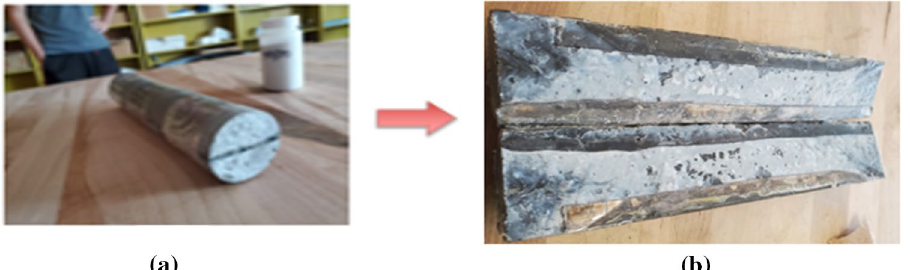
Fig. 1 A cut cement core sec- tion. a Fractured core before gel placement, b fractured core filled with gel